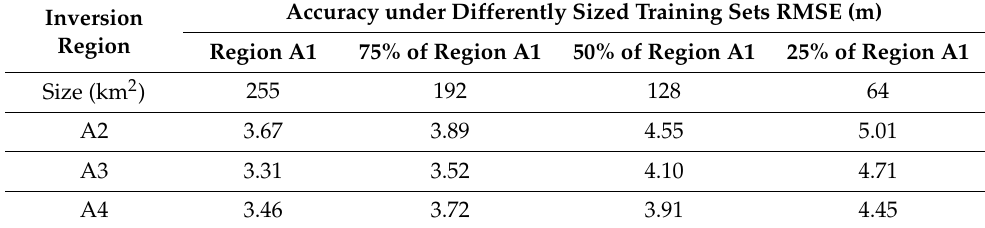
Table 5. Validation accuracy of regions A2, A3, and A4 for different training set